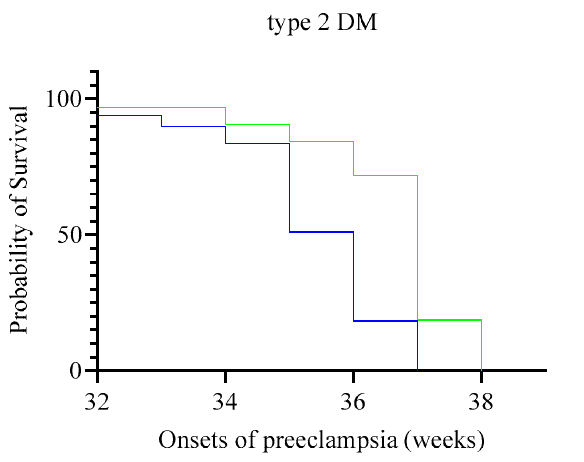
Figure 4. Onsets of preeclampsia in patients with type 2 DM.